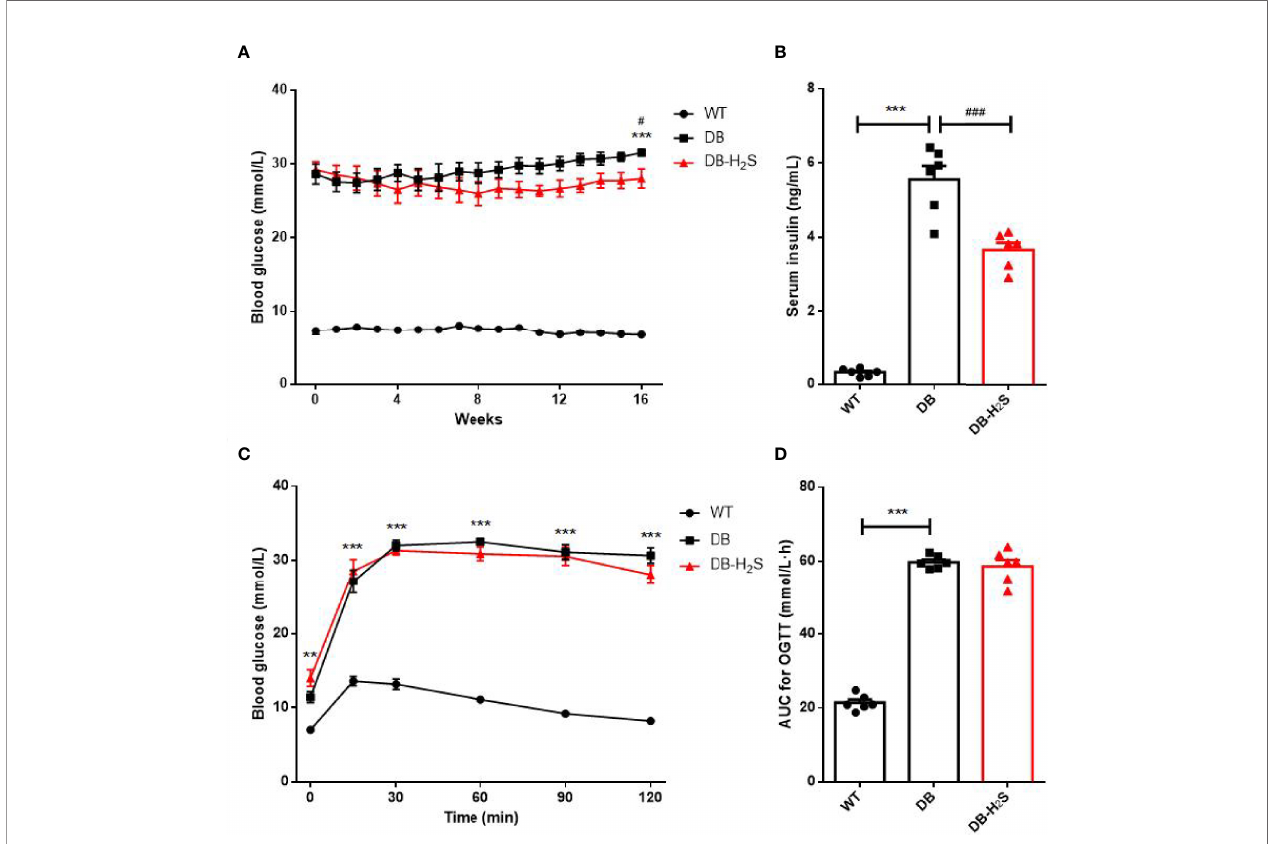
FIGURE 2 | Effects of exogenous H 2 S on glucose homeostasis. (A) Random blood glucose. (B) Serum insulin level at week 16. (C) Oral glucose tolerance test (OGTT) at week 16. (D) Area under the curve (AUC) for the OGTT. WT, wild-type mouse group (n = 6); DB, db/db mouse group (n = 6); DB-H 2 S, db/db mouse treated with NaHS group (n = 6). Data are shown as mean ± SEM. Differences were analyzed by one-way ANOVA with Tukey ’ s multiple-comparison test and denoted as follows: ** p < 0.01, *** p < 0.001, WT vs. DB; # p < 0.05, ### p < 0.001, DB-H 2 S vs.